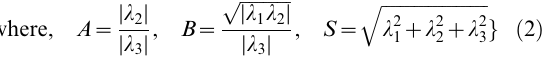
PLOS Computational Biology |